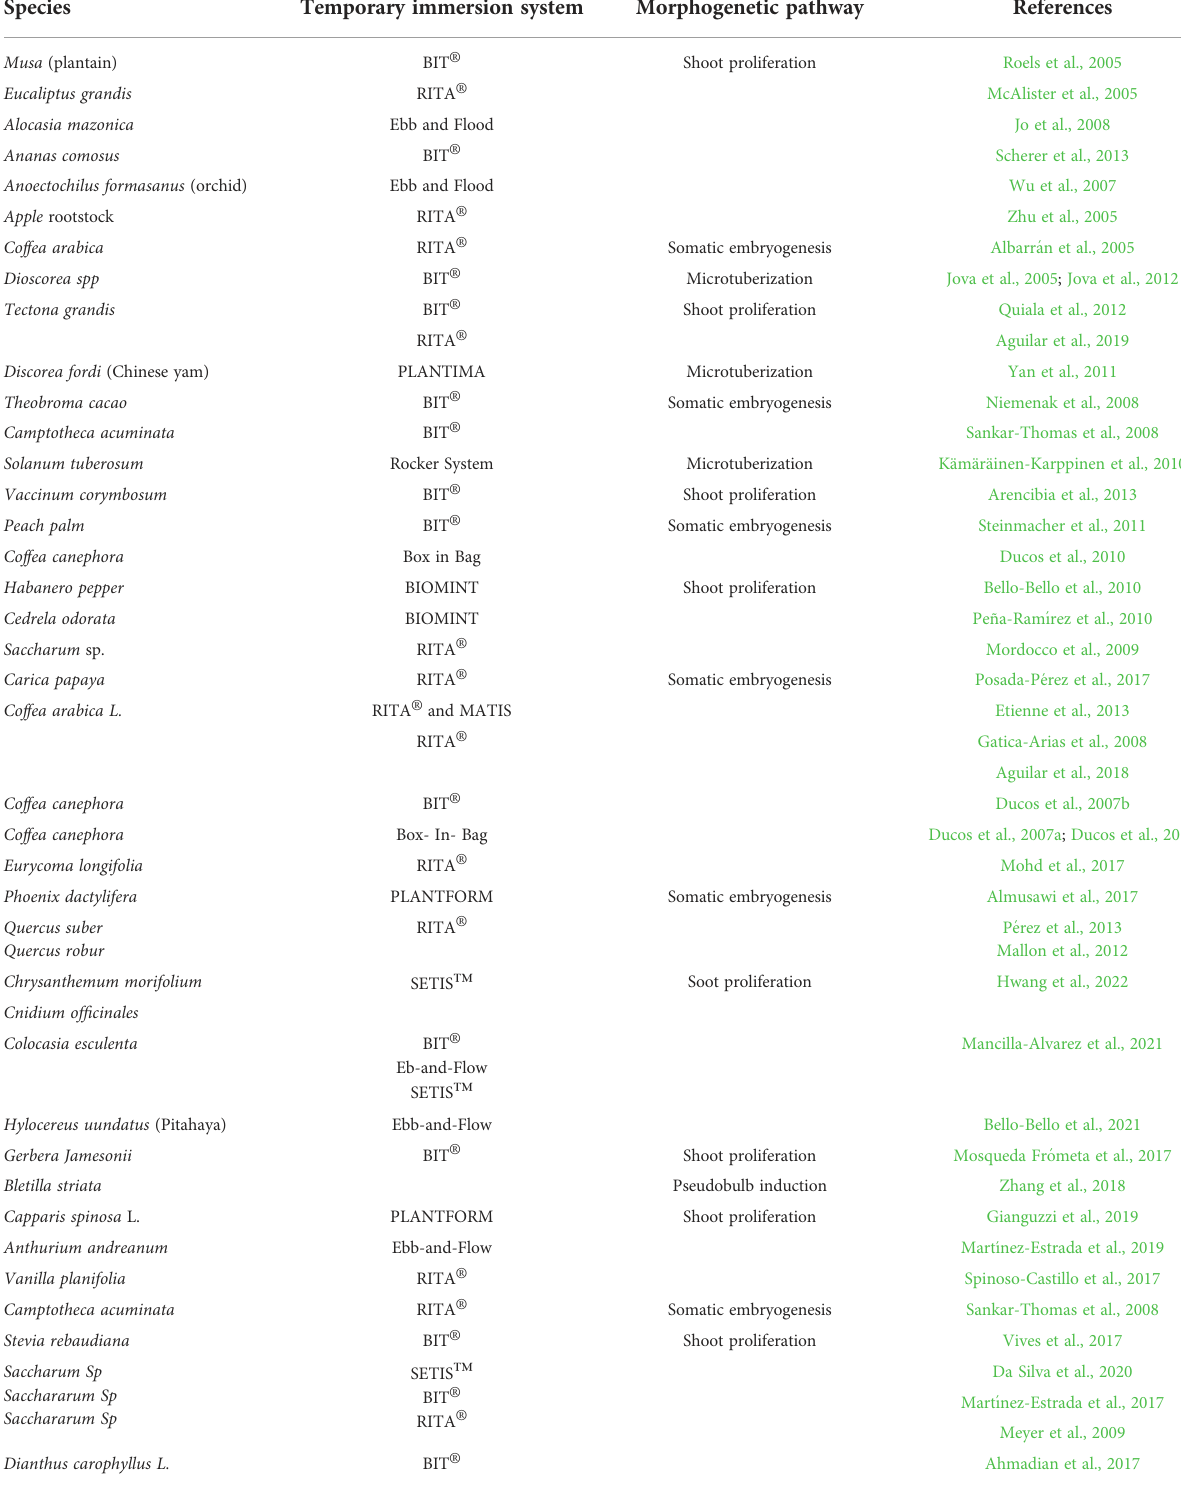
TABLE 3 Representative summary of type of temporary immersion systems and morphogenetic pathway since